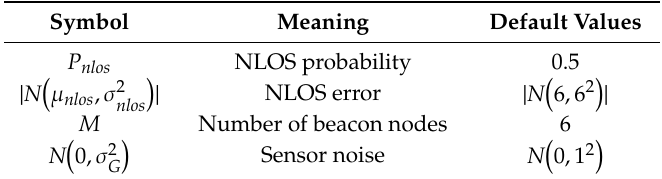
Table 2. The default parameters for Gaussian distribution.